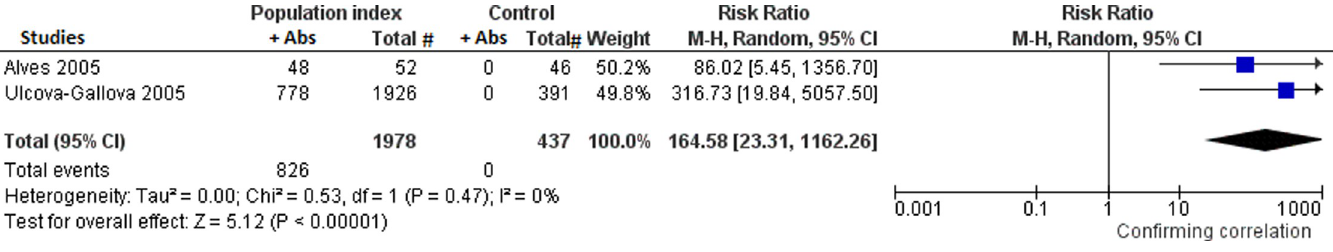
Fig 8. Meta-analysis assessing the risk for implantation failure in relation to the presence or not of anti-PL antibodies in the studies in subgroup B between women with at least two implantation failures in IVF-ET ( population index ) vs women with at least one successful spontaneous pregnancy or unselected healthy fertile women with no history of IVF-ET ( control ). Fig 8: meta-analysis assessing the risk for implantation failure in relation to the presence or not of anti-PS antibodies. +Abs: positive antibodies, total #: total number of